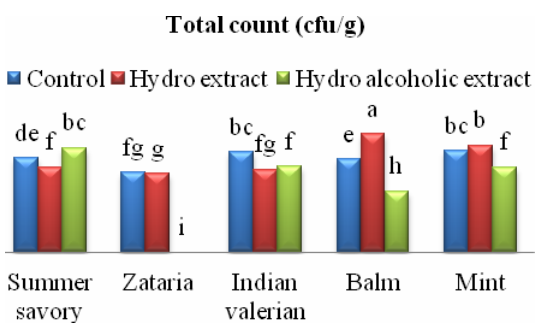
Fig. 1. Mean comparison of total count, in hydro and hydro alcoholic extract